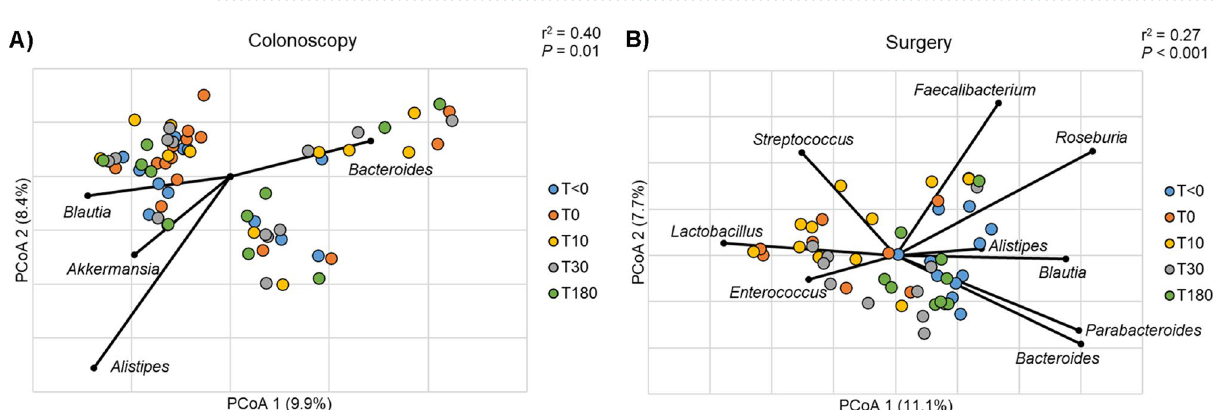
Figure 2. Change in microbial composition over study course as determined by SourceTracker. Percent similarity of intra- and postoperative samples of individual patients to their own preoperative sample among patients that underwent ( A ) colonoscopy and ( B ) surgery.